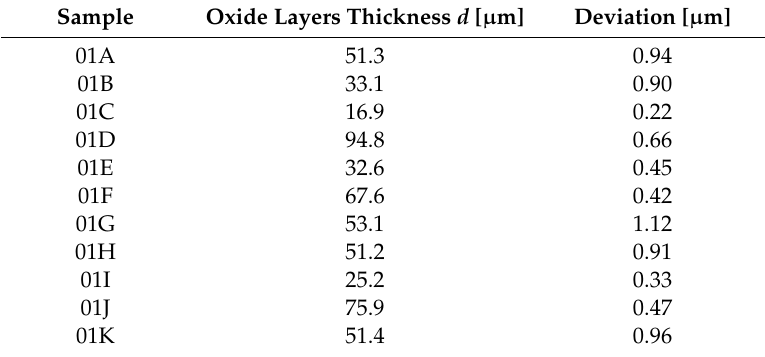
Table 3. List of Al 2 O 3 coating thicknesses produced in anodizing process (without thermo-chemical